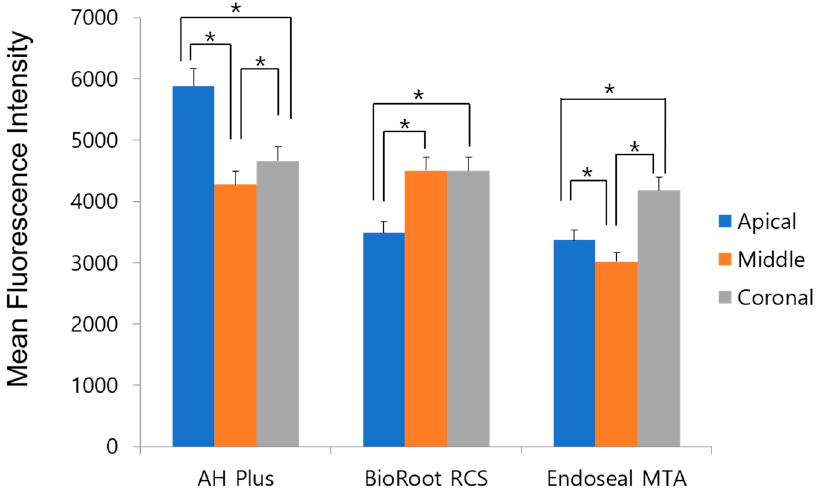
Figure 4. Mean fluorescence intensity of rhodamine B in all experimental sealers. Stars indicate a statistically significant difference.